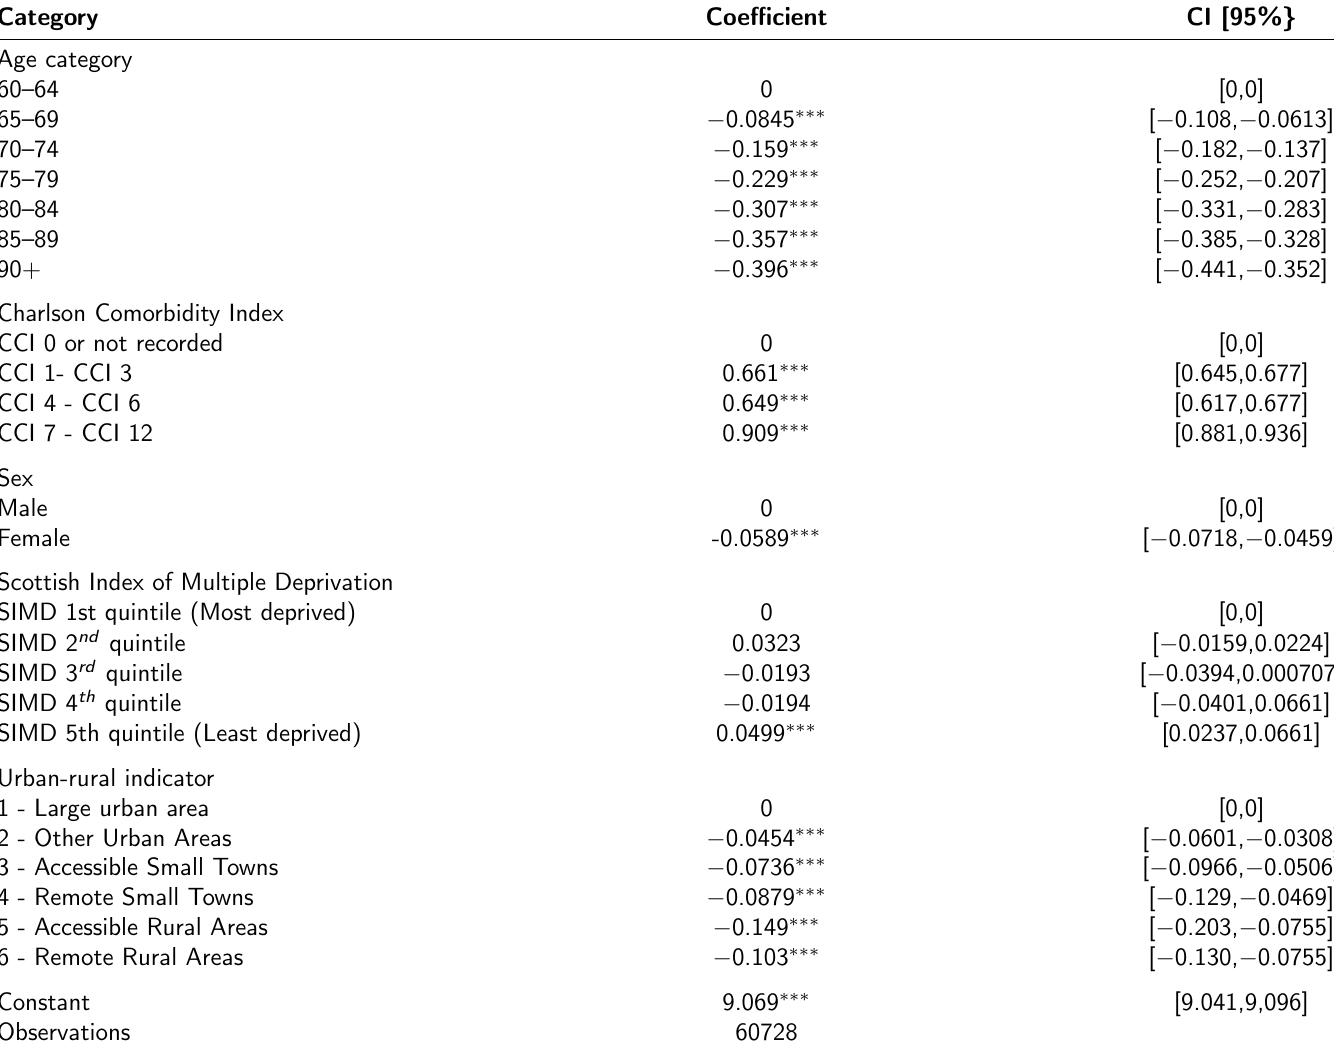
Table 3: Generalised linear model – multivariate Analysis, for patients with cancer as a primary cause of